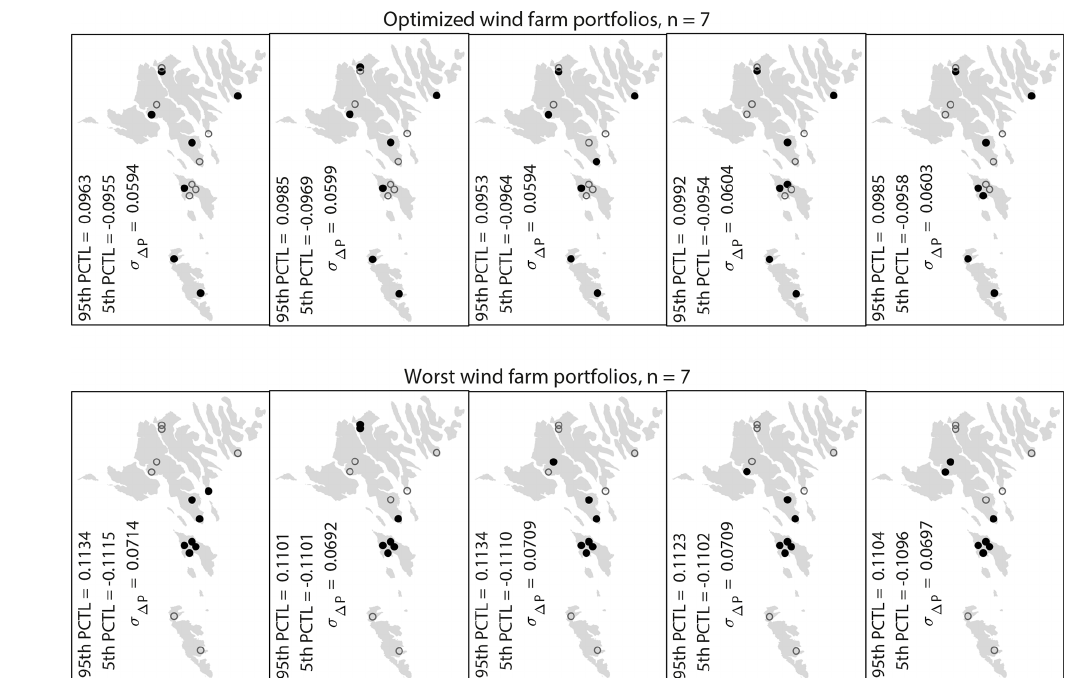
Figure 9. Examples of the optimized (top) and the worst (bottom) wind farm portfolios with seven wind farms (black filled circles) where the rated power at each wind farm is the same. The open circles mark the locations that are not selected. These examples are the portfolios with smallest (optimized portfolios) and largest (worst portfolios) integrals of the PSD with respect to frequencies from (3h) − 1 to (2h) − 1 out of all possible combinations of seven wind farms. The 5th and 95th percentiles (PCTL) and the standard deviation of the hourly step-change function of the total wind power time series per installed power are given in the bottom left corner of each example.